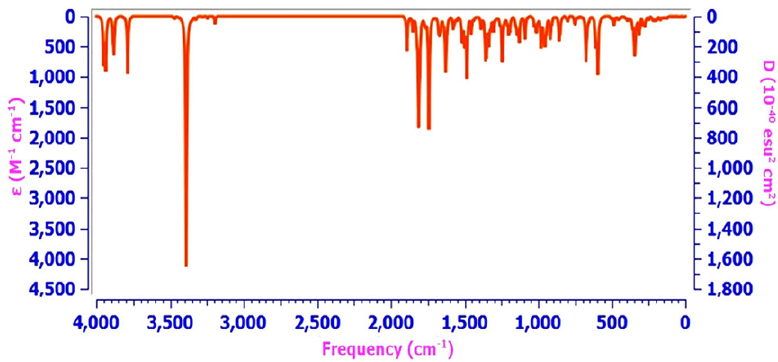
Fig. 3b . Theoretical FT-IR spectrum of Nickel Transition Metal with MBHA (L1)